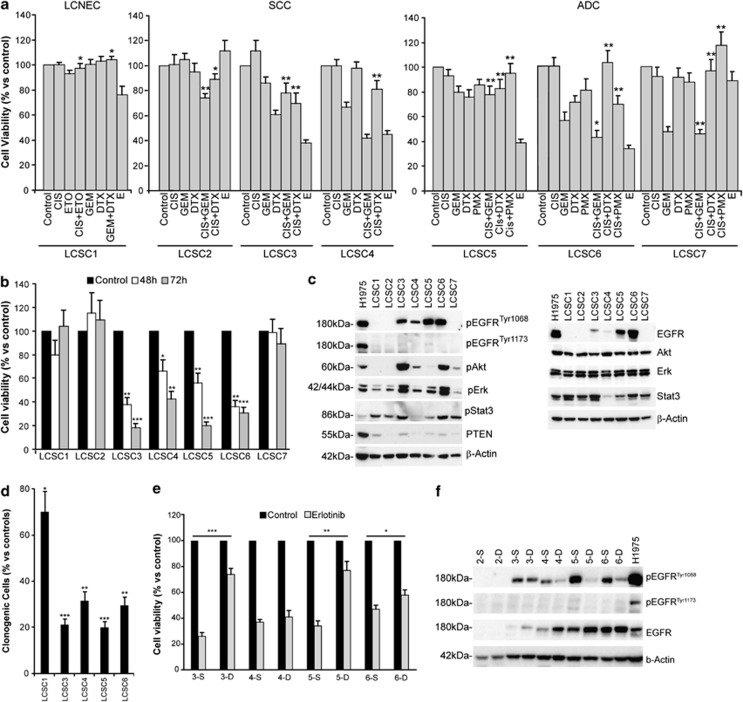
Cytotoxic activity of chemotherapy or erlotinib and EGFR pathway activation in LCSCs. (a) LCSCs were exposed to the indicated drugs and cell viability evaluated after 48 h and indicated as percentage versus control cells. (b) Time course of erlotinib-induced cytotoxicity. Cell viability was evaluated by CellTiter-Glo after 48 and 72 h of erlotinib exposure. (c) Immunoblot analysis of the indicated components of the EGFR pathways. (d) Long-term effects of erlotinib on LCSCs. Percentage of clonogenic cells in soft agar assay of erlotinib-treated versus control is indicated for each LCSC analyzed. (e) Cytotoxic activity of erlotinib in LCSCs (-S) and corresponding differentiated cells (-D) of each sample as indicated. Cells were exposed to erlotinib for 3 days and cell viability evaluated by CellTiter-Glo. (f) Immunoblot comparison of EGFR expression and activation in LCSCs (-S) and their in vitro differentiated counterparts (-D). Mean±S.D. of three independent experiments is always shown. *P<0.05; **P<0.01; ***P<0.001